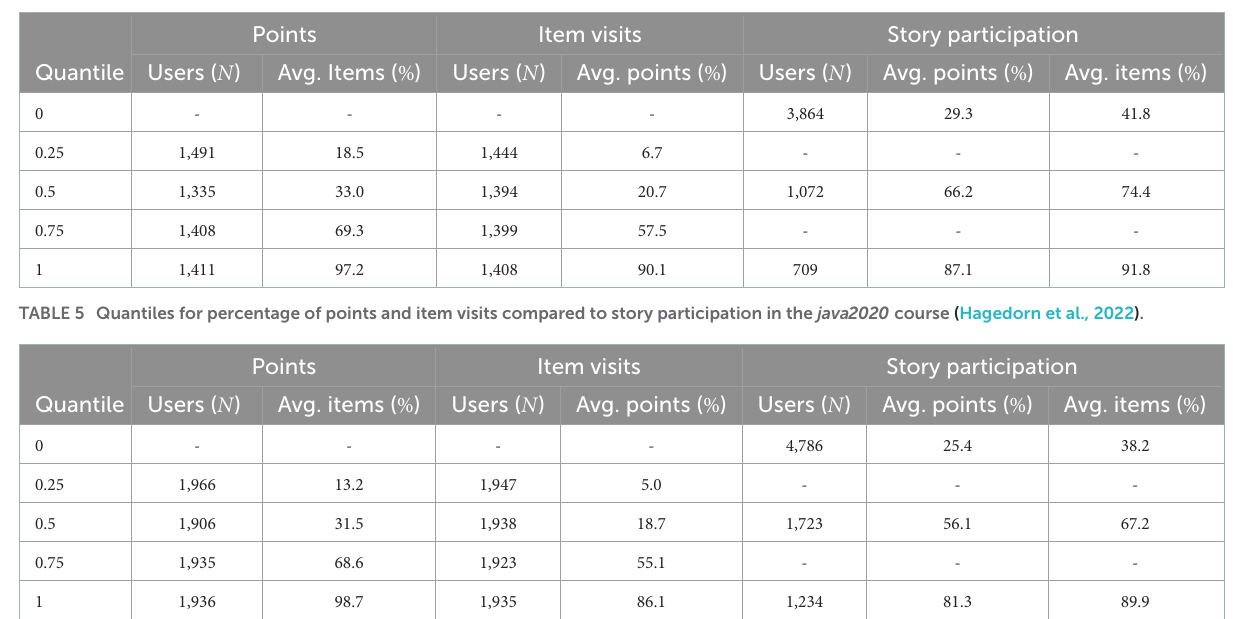
TABLE 4 Quantiles for percentage of points and item visits compared to story participation in the java2017 course (Hagedorn et al., 2022). Points Item visits Story participation Quantile Users ( N )